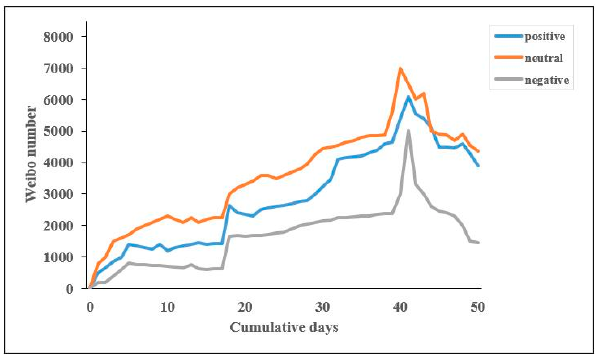
Figure 6. Distribution of reviews over